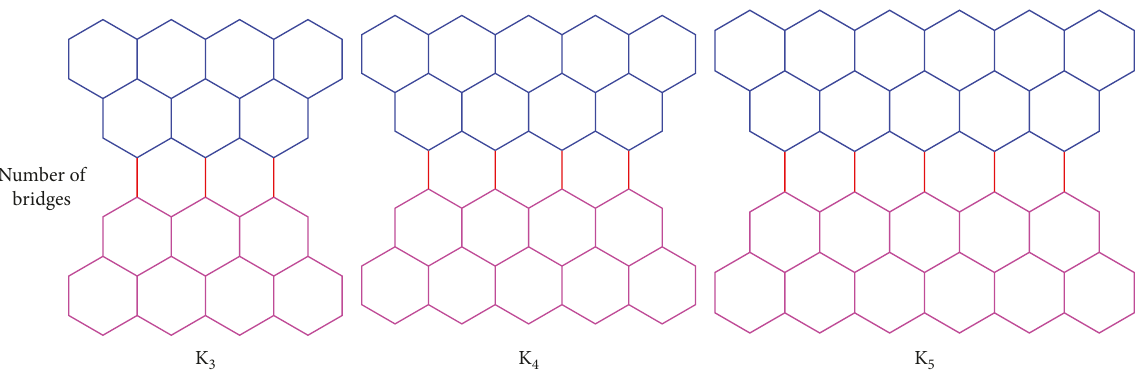
Figure 1: Non-Kekulean benzenoid graphs K Table 1: Atom-bonds-based partition of each atom of K